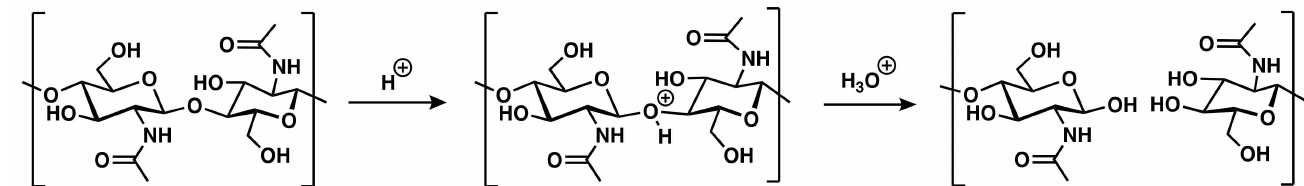
Figure 2. Acidolysis reaction of the β -1,4-glycosidic bond of